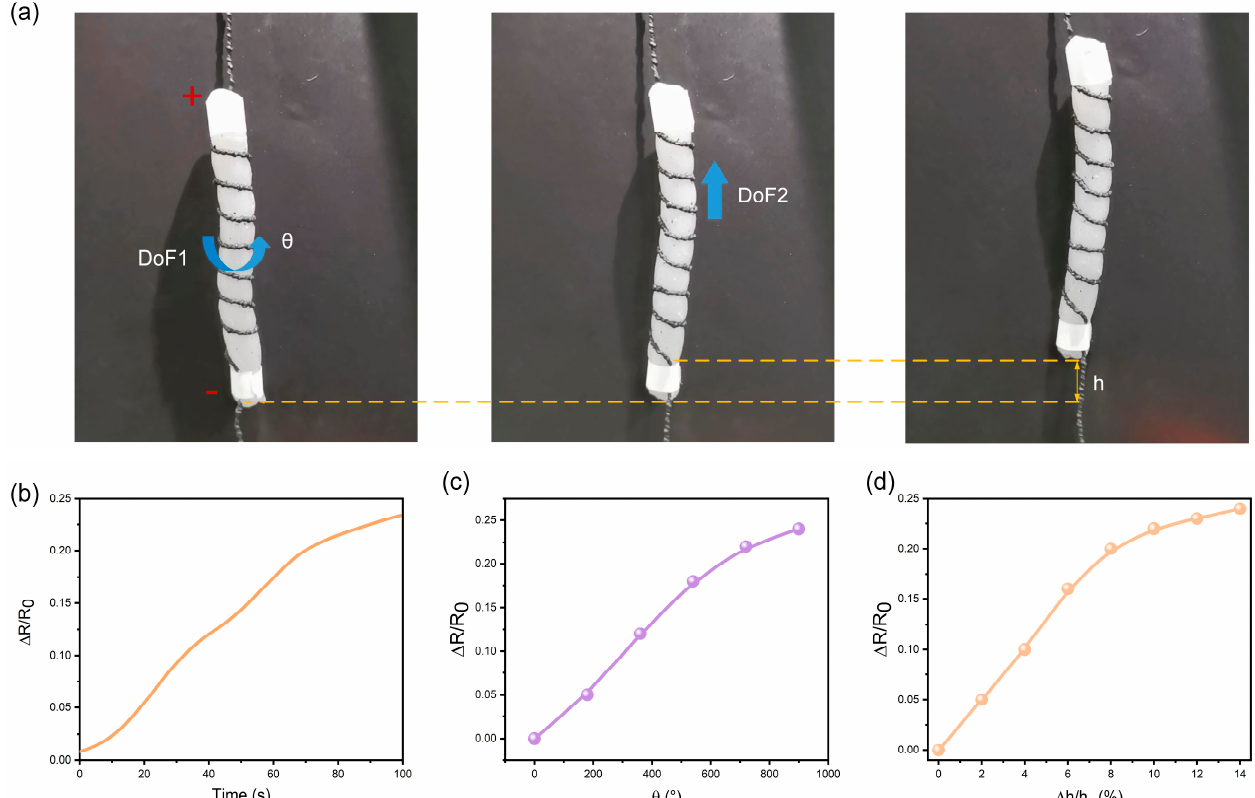
Figure 6. Application demonstrations of the yarn muscle entangled soft actuators. ( a ) The picture of yarn muscle entangled soft actuators and the process of twisting (DoF1) and lifting (DoF2); ( b ) The resistance changes of the artificial muscle fiber in the contraction process under 20 V; ( c ) The resistance changes of the yarn muscle with the twisting angle; ( d ) The resistance of the yarn muscle the lifting height ratio. DoF: degrees of freedom.